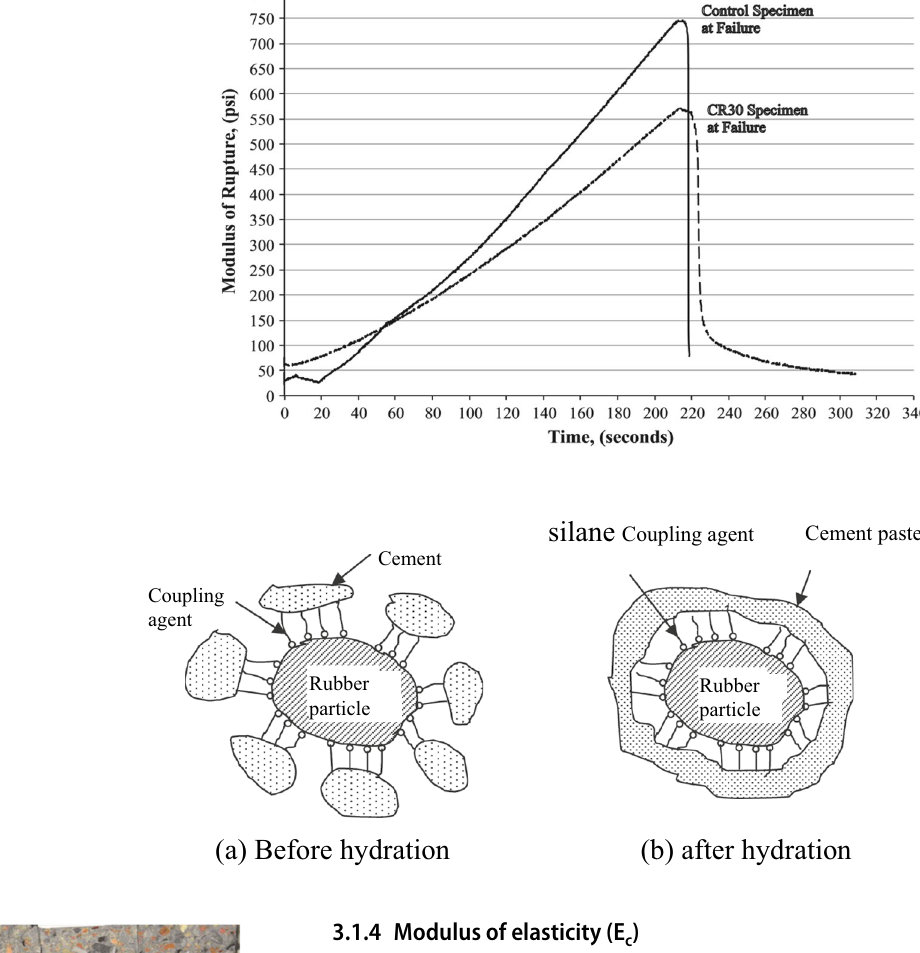
Fig. 10 Flexural failure behav- iour of rubberized concrete [31]